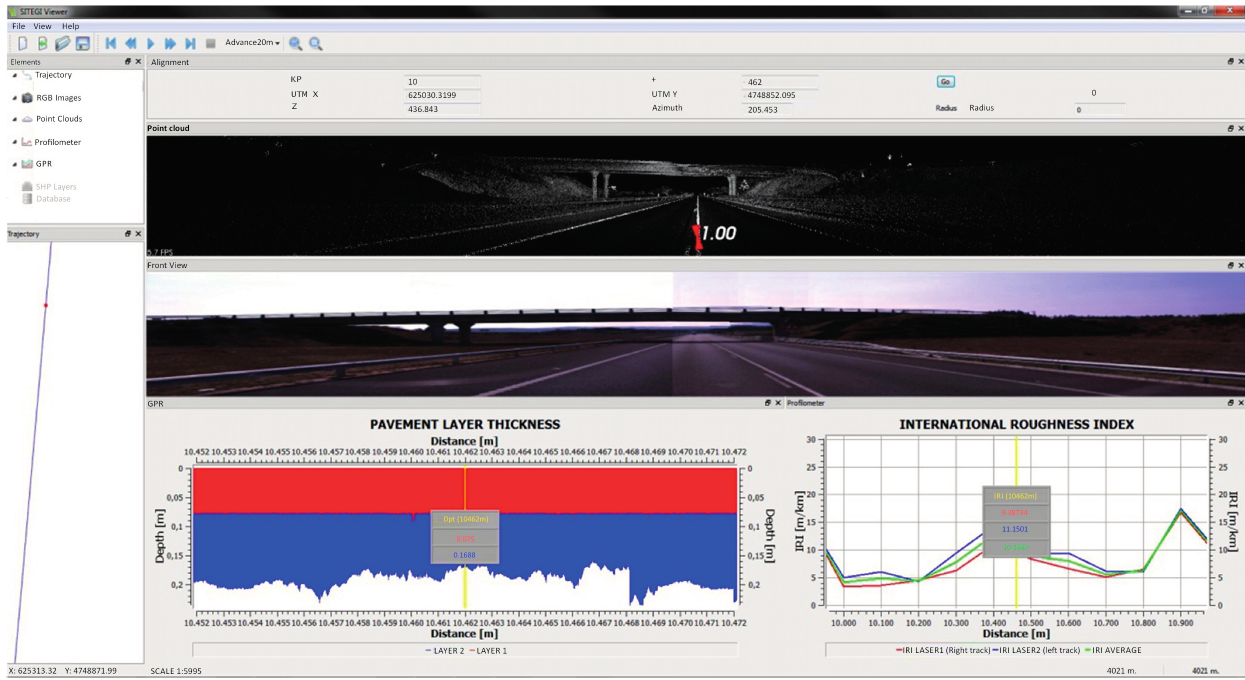
Figure 11. Road management software interface with windows showing the data acquired from different